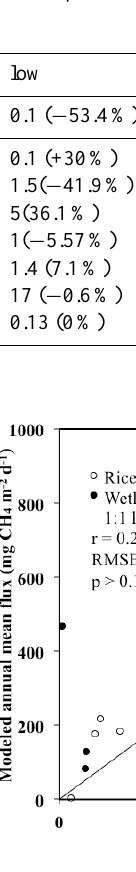
Fig.12. Comparison of mean methane fluxes (mg CH 4 m -2 d -1 ) extracted from the closest gridcells in the global simulation with observations at sites. We found a poor correlation between them possibly due to the spatial heterogeneity and large spatial resolution in the global simulation and other errors associated with this model.